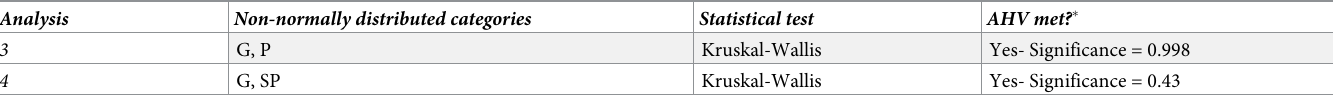
Table 6. Details of statistical procedures for the non-parametric tests.